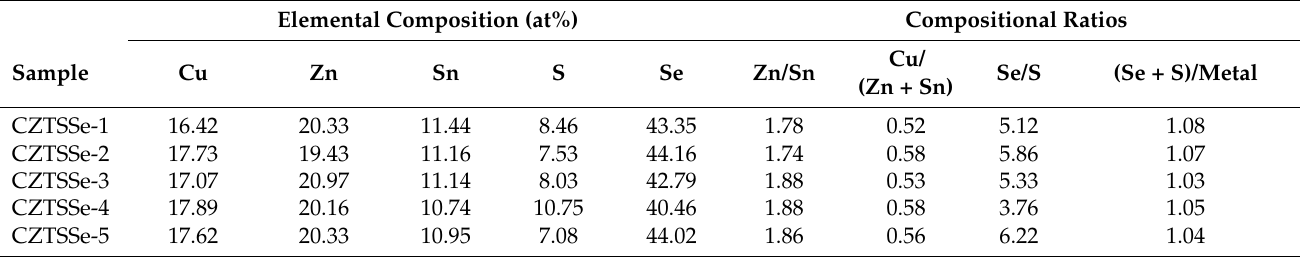
Table 1. Elemental composition and compositional ratios of the CZTSSe absorber